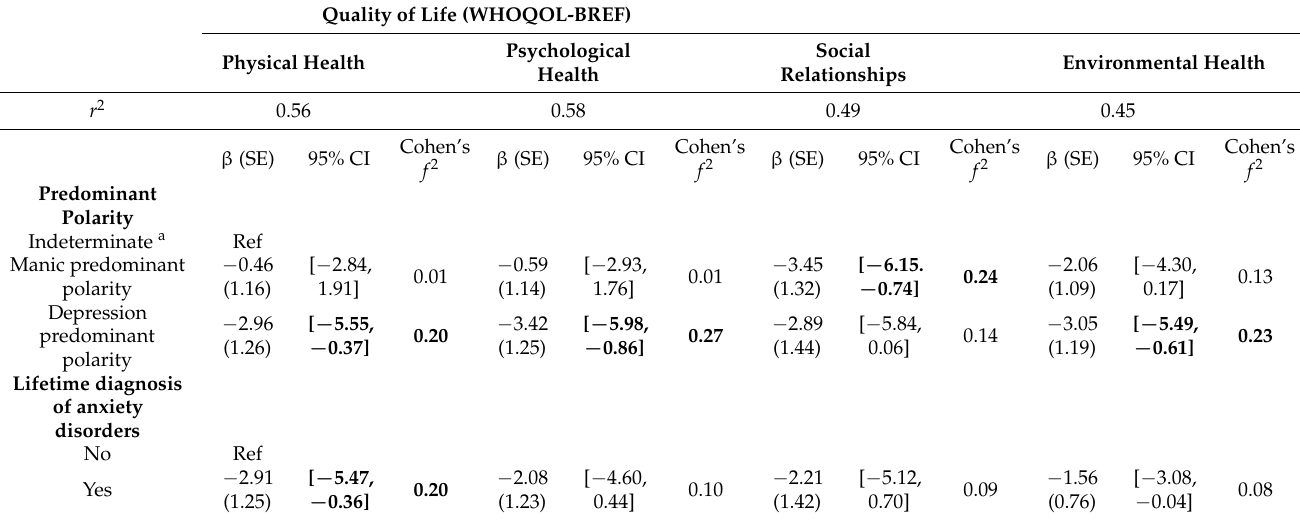
Table 2. Summary of general linear model parameter estimates for WHOQOL-BREF scores for physical health, psychological health, social relationships and